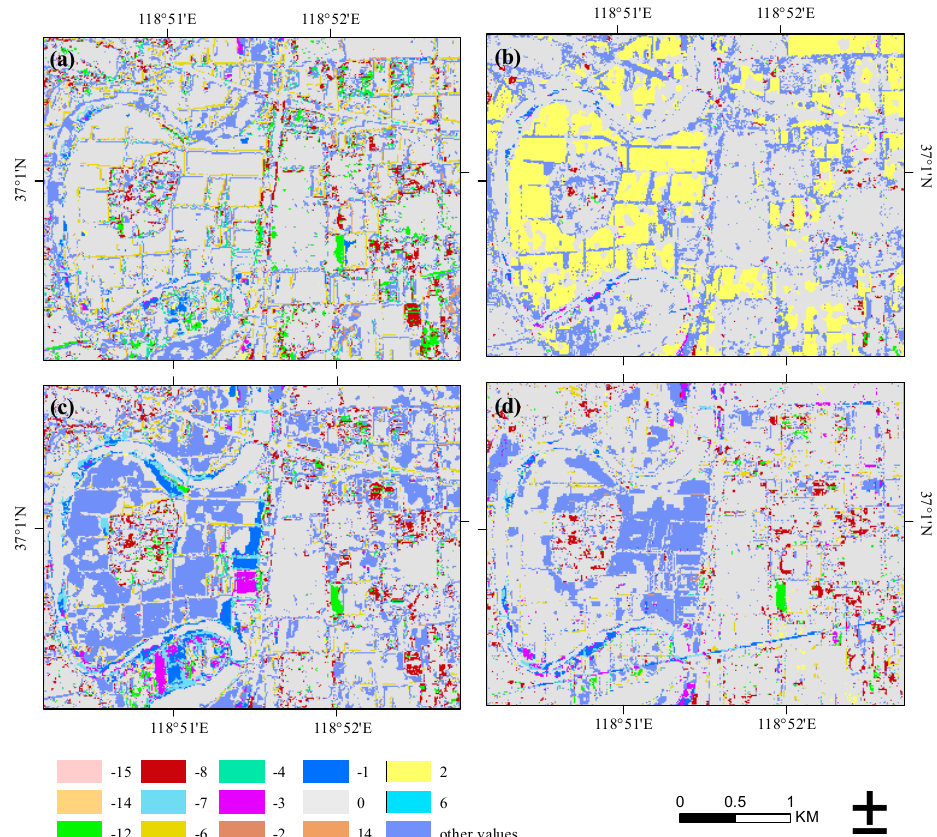
Figure 5. The change detection of classifications. ( a ) Change detection results between 2 August 2018 and 21 July 2018; ( b ) Change detection results between 2 August 2018 and b27 July 2018; ( c ) Change detection results between 2 August 2018 and 20 August 2018; and ( d ) Change detection results between 2 August 2018 and 26 August 2018.